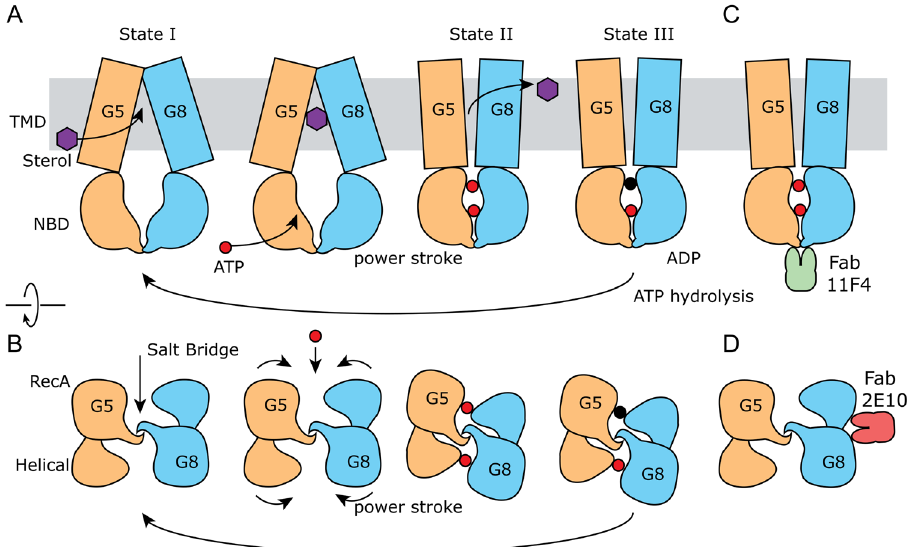
Fig. 5 Schematic model of sterol transport by ABCG5/G8 and Fab binding. A The sterol transport cycle of ABCG5/G8 viewed from the side of the membrane. B Conformational changes of NBDs in the transport cycle of ABCG5/G8 viewed from the side of cytosol. Detailed descriptions of the transport cycle of ABCG5/G8 can be found in the “ Discussion ” section. C Fab 11F4 (green) interacts with the dimer interface of the NBDs, which stabilizes the dimerization of NBDs favoring ATP hydrolysis. D Fab 2E10 (red) interacts with both the RecA and helical domains of ABCG8, which restricts the relative movement between the RecA and helical domains and decreases ATP